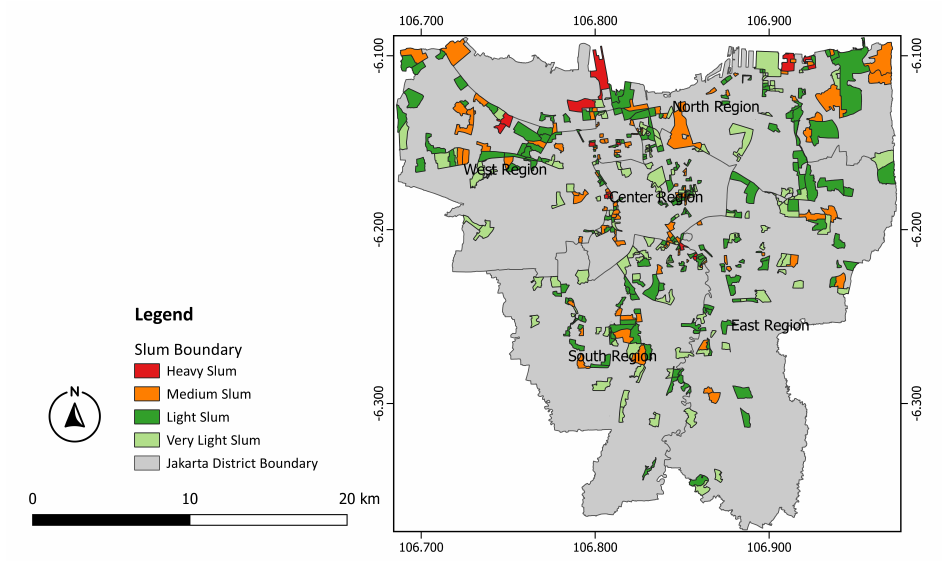
Figure 2. Official slum boundaries from 2017 showing heavy, medium, light and very light